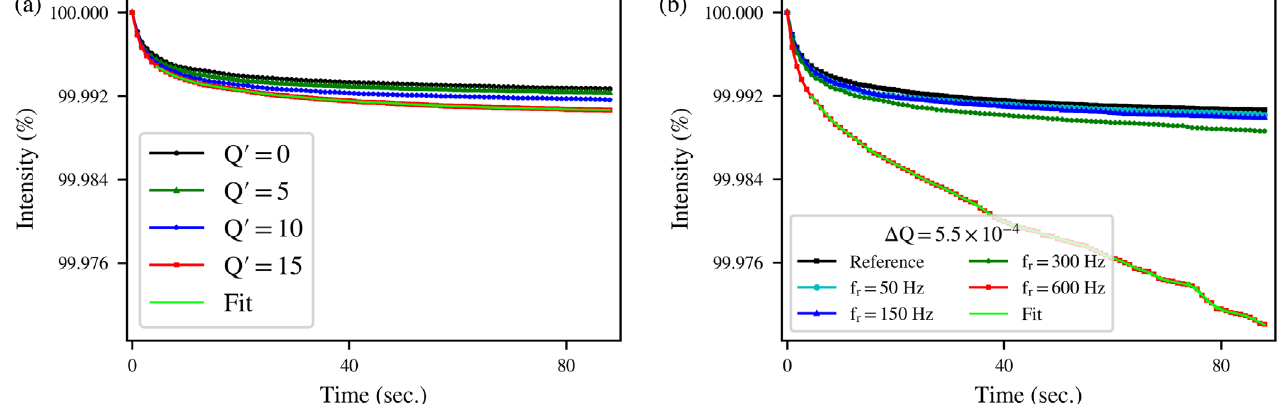
FIG. 5. (a) Intensity evolution in the HL-LHC lattice, including beam-beam interactions and with the simulation parameters of Table II, for a horizontal and vertical chromaticity of Q 0 ¼ 0 (black), Q 0 ¼ 5 (green), Q 0 ¼ 10 (blue), and Q 0 ¼ 15 (red). (b) Intensity evolution for Q 0 ¼ 15 without power supply ripple (black) and in the presence of a tune modulation with Δ Q ¼ 5 . 5 × 10 − 5 at 50 Hz (cyan), 150 Hz (blue), 300 Hz (green), and 600 Hz (red). An important impact is observed at 600 Hz due to the excitation of the m ¼ 1 and N ¼ 3 resonance. The fits for the estimation of the instantaneous lifetime [Eq. (15)] are also illustrated (light green).